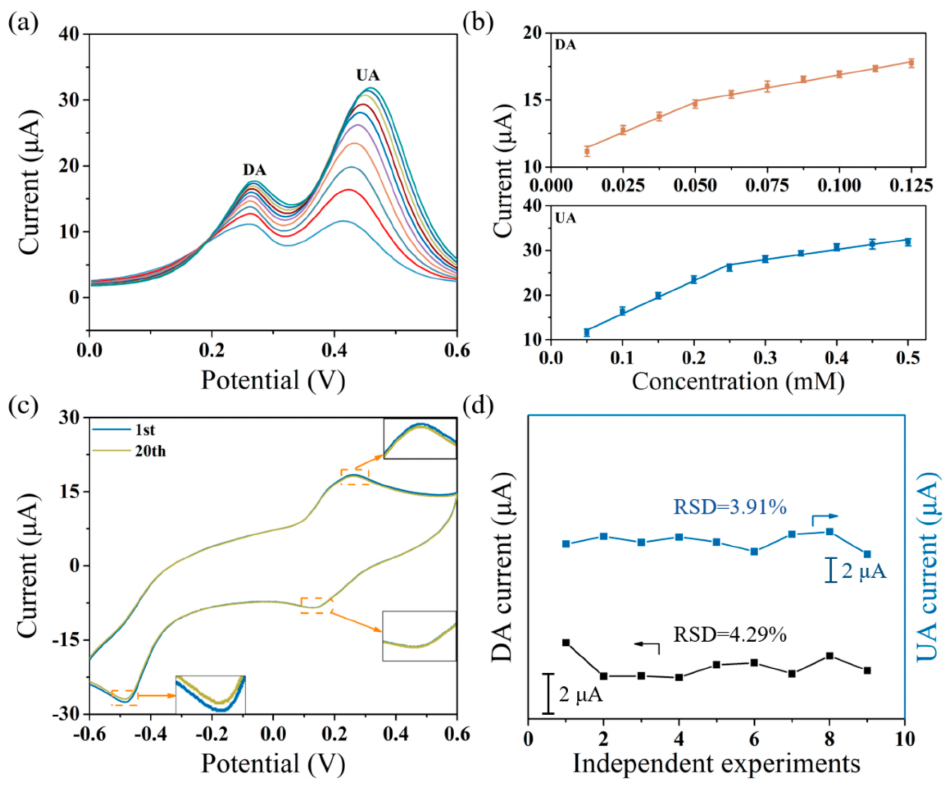
Figure 6. ( a ) DPV responses of the MXene/PPy modified electrode for the mixture containing DA (12.5–125 µ M), UA (50–500 µ M), and 1 mM AA; ( b ) the linear calibration curves for the current response of DA and UA; ( c ) the stability of the as-prepared sensor after scanning in 0.05 M PBS for 20 cycles; ( d ) the reproducibility of the as-prepared sensor in 0.05 M PBS containing 50 µ M DA and 100 µ M